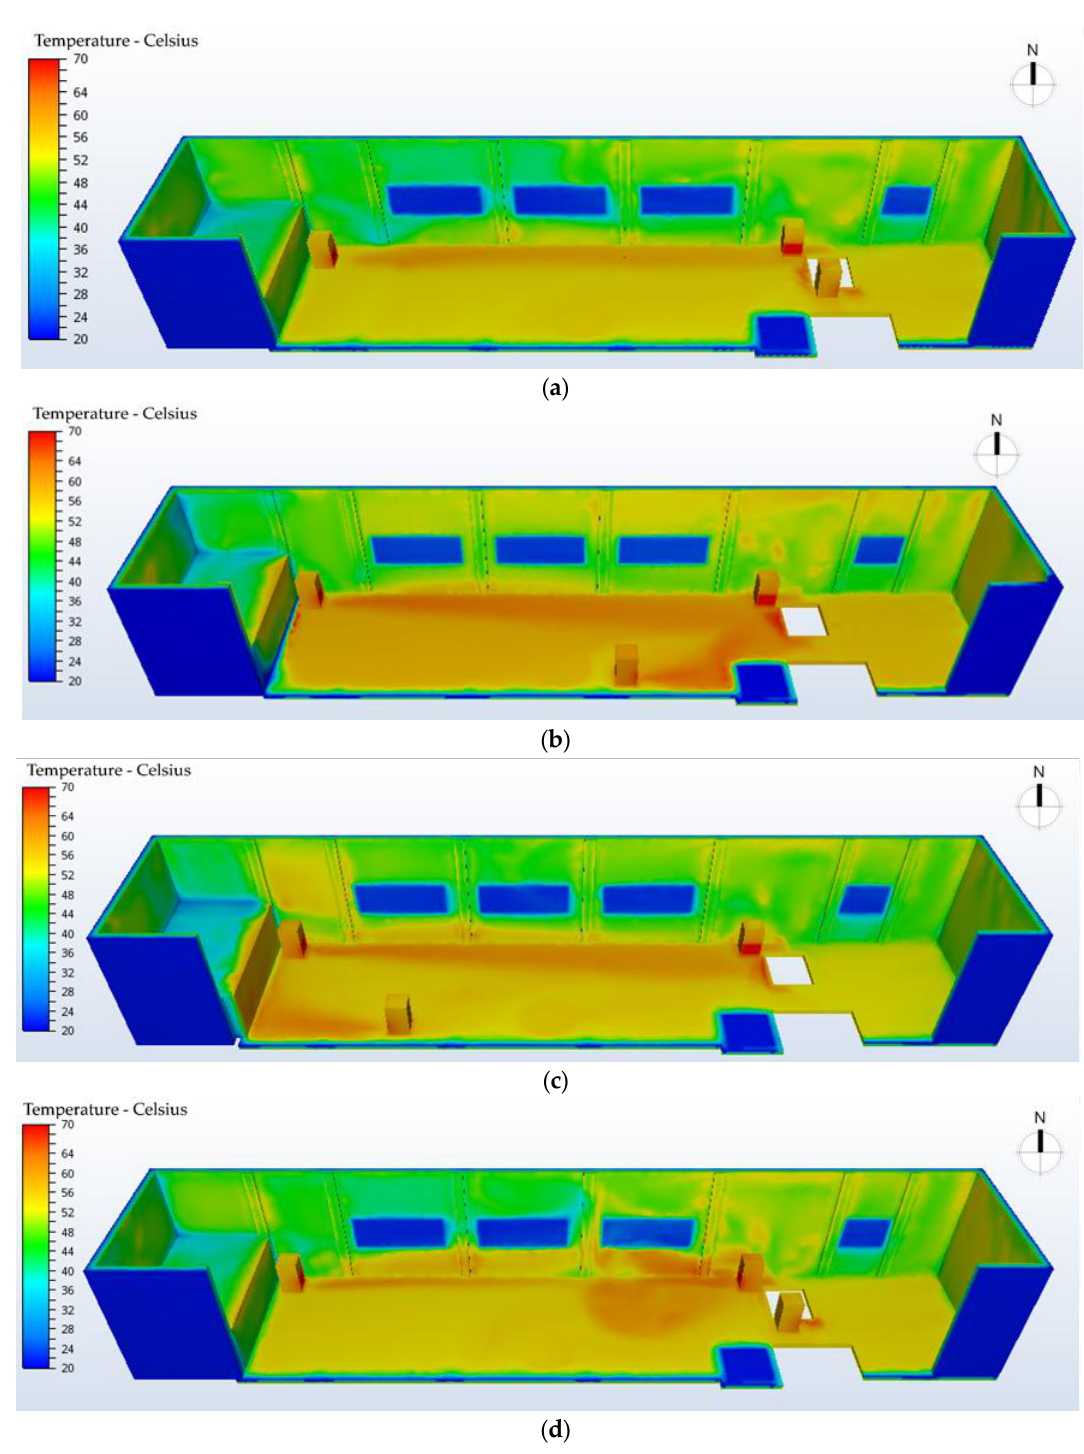
Figure 6. Perspective view (without showing machinery) of the south wall. ( a ) Initial configuration, ( b – f ) changes in the position/orientation of the fan heaters.